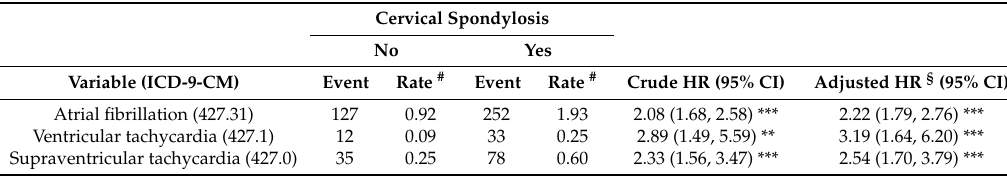
Table 6. Comparison of incidence densities of different types of arrhythmia and Cox model measured hazard ratio between patients with and without cervical